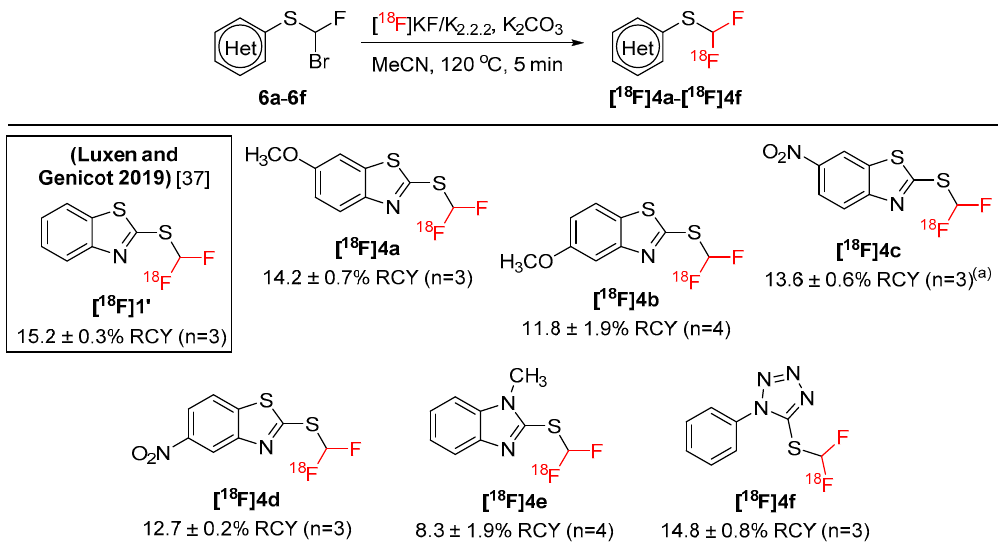
Table 1. Optimization of the oxidation conditions of the [ 18 F]4a